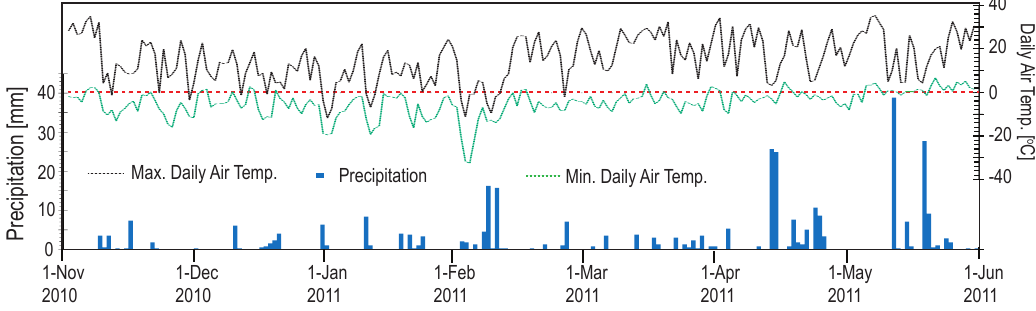
Fig. 2. Time series of precipitation and air temperature from the nearby Sugarloaf climate station (CO94) operated by the NADP program. The dashed red line marks 0 ◦ C air temperature.